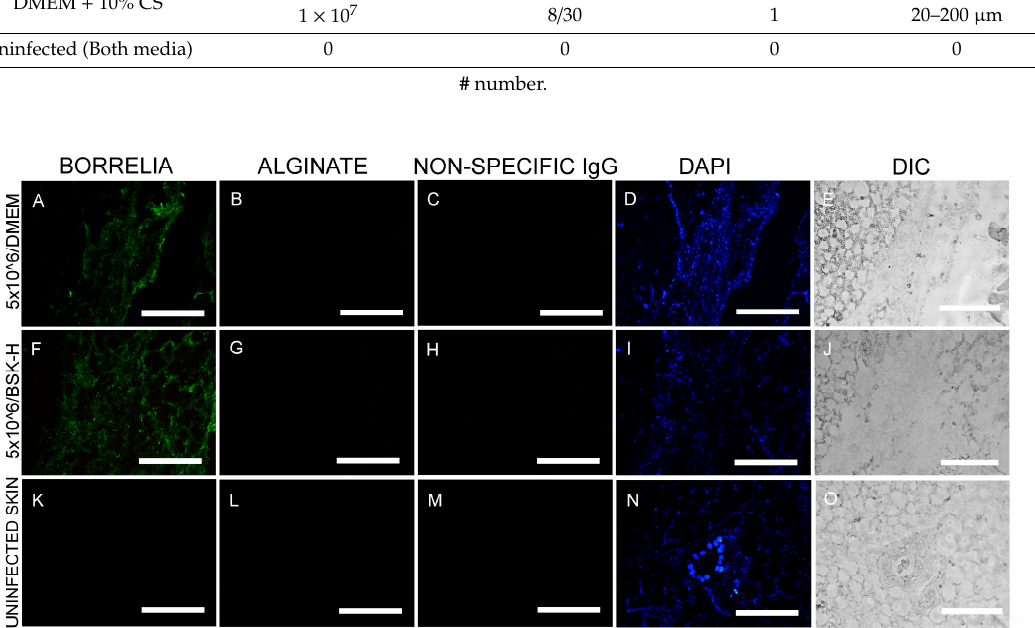
Figure 1. Representative images of immunohistochemical (IHC) experiments for B. burgdorferi in murine skin biopsies inoculated at 5 × 10 6 cells. Panels ( A , F , K ) show the results for anti- B. burgdorferi and panels ( B , G , L ) for anti-alginate antibodies. DAPI nuclear stains (blue staining: panels ( D , I , N )) and differential interference contrast microscopy (panels ( E , J , O )) were used to visualize the skin biopsy tissues. Negative controls include staining of uninfected skin (panels ( K , L )) and the use of a non-specific IgG (panels ( C , H , M )). 400× magnification, scale bars show 200 μ m.